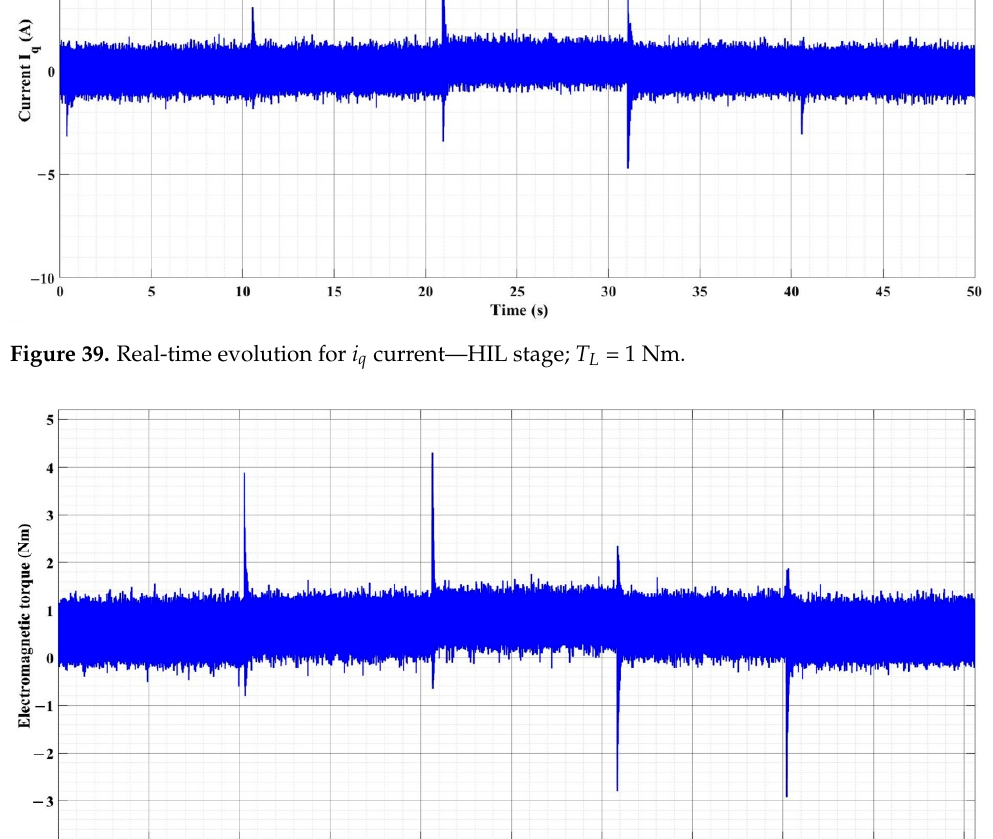
Figure 40. Real-time evolution for the electromagnetic torque of the PMSM—HIL stage; T L = 1 Nm.